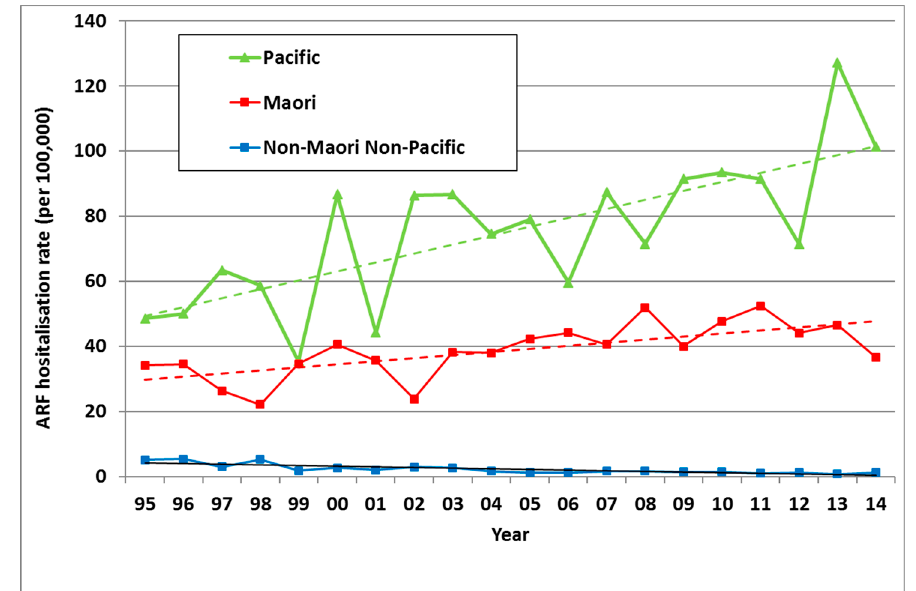
Figure 5. ARF incidence by prioritised ethnicity and year, initial hospitalisation rate per 100,000, 5–14 year olds, 1995 to 2014.